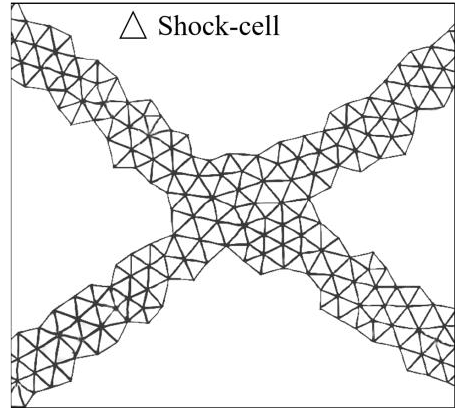
Figure 2. Detected shock-cells.